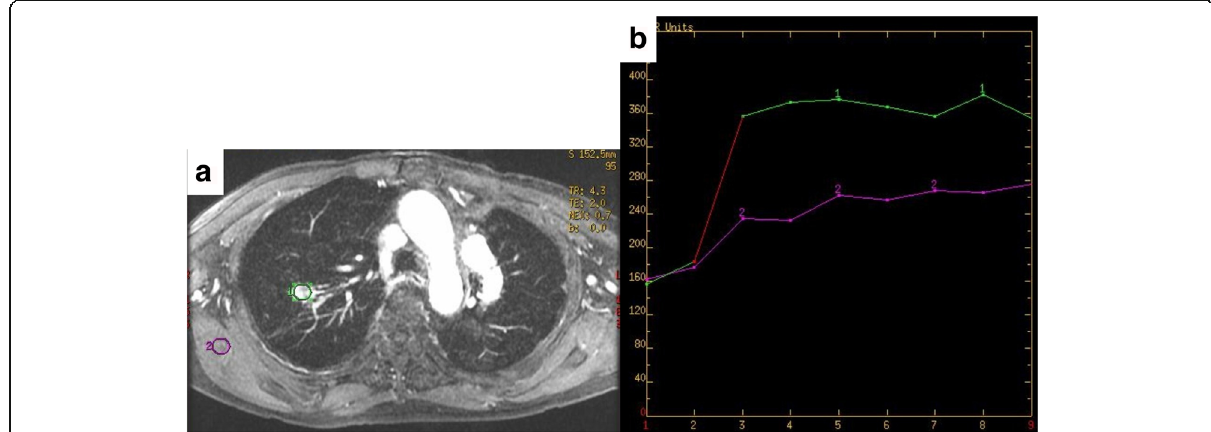
Fig. 4 a Dynamic magnetic resonance imaging showing contrast enhancement effect in the solid nodule on the cut-end of the residual right upper lobe. b Graph showing time-intensity curve compared to normal muscular tissue of the chest